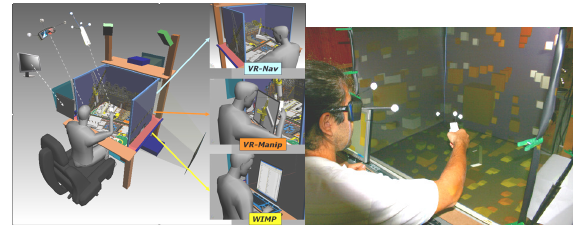
Figure 3. HybridDesk scheme with its three interactive environments and its use in the navigation mode.